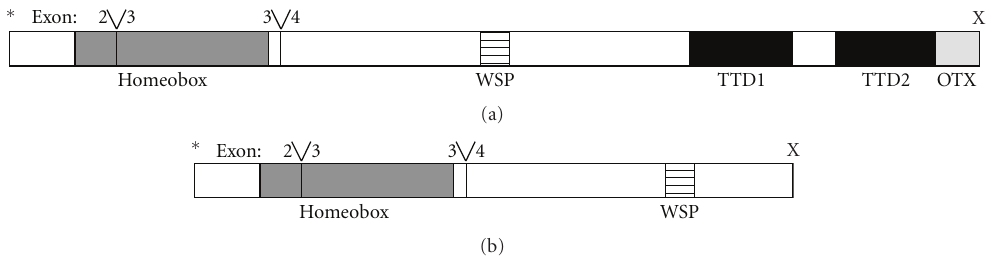
Figure 4: CRX protein structure in Felis catus . Wildtype feline CRX protein (a) compared to the putative truncated CRX protein (b). The exon splice junctions are noted as “Y”. The start codon and stop codons are labeled as ( ∗ ) and (X), respectively. The protein domains are highlighted as shaded boxes and defined as the homeobox, the WSP domain, the transcriptional transactivation domains 1 and 2 (TTD1 and TTD2), and the OTX tail. Domains are drawn to scale. Reproduced with permission from